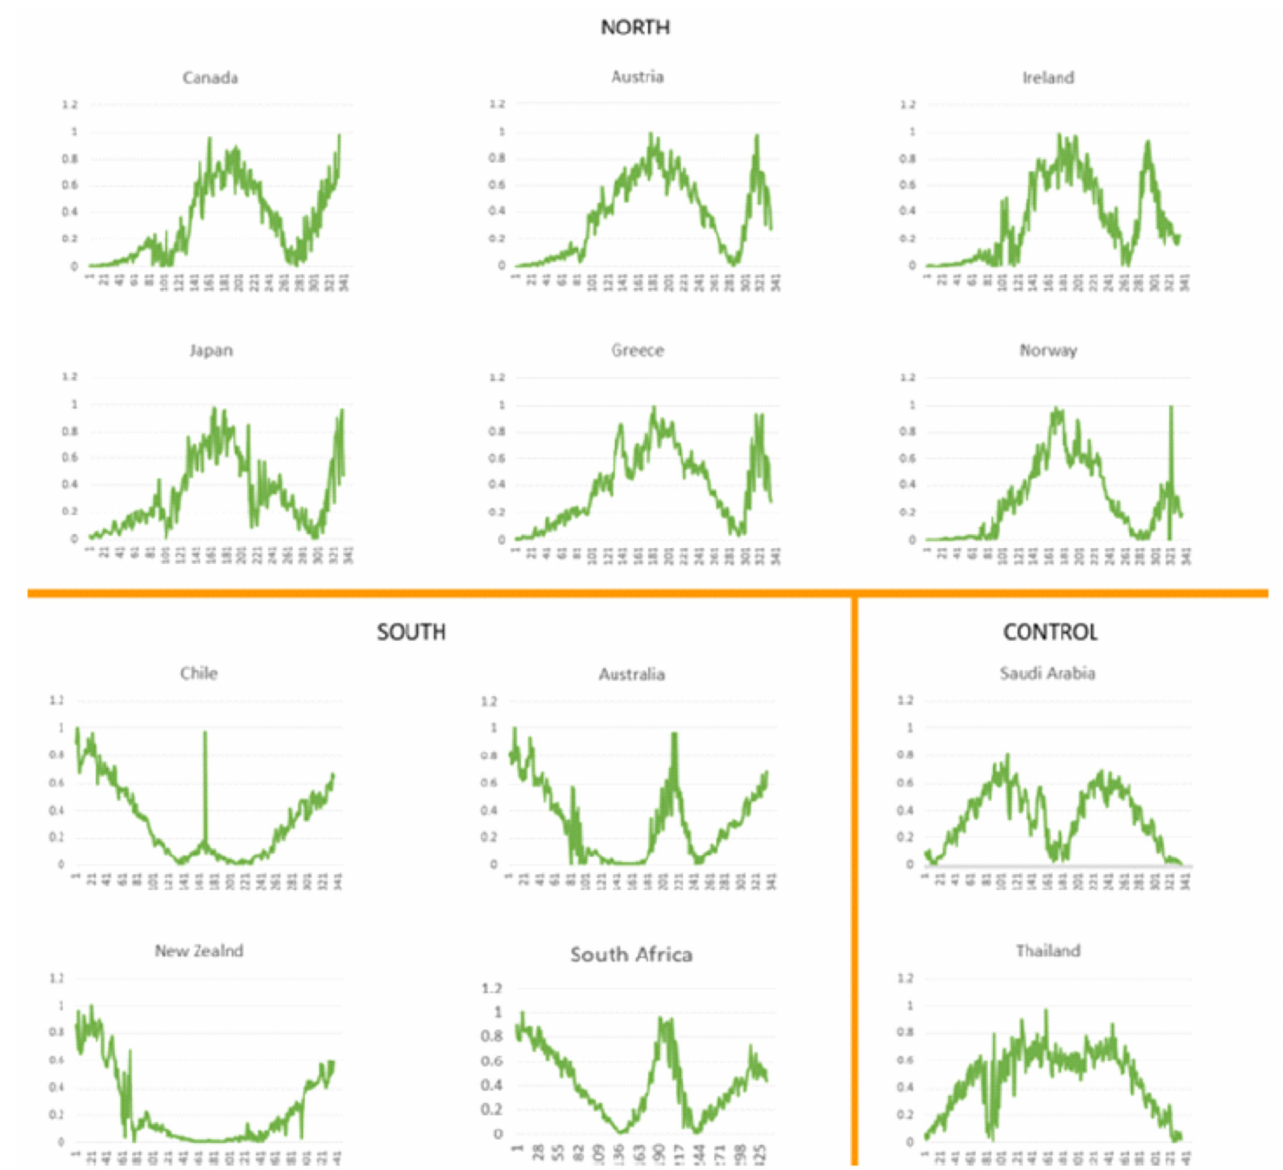
Figure 5. Absolute difference distributions between normalized daily cases and UV radiation levels. The twelve target countries are shown, the top half belonging to the Northern Hemisphere, the bottom right (two) being the (near-equatorial) control countries and the remaining bottom left (four) belonging to the Southern Hemisphere. The spike in the case of Chile is due to an irregularity of reporting backdated cases (see Methods). A smoothed average would have the side values more pronounced, resembling those of South Africa, despite different restrictive measures and other, unpredictable human factors or incidents. The SSQ metric (Table 2) can also be used as a summary statistic and a single-value comparative measure for all target